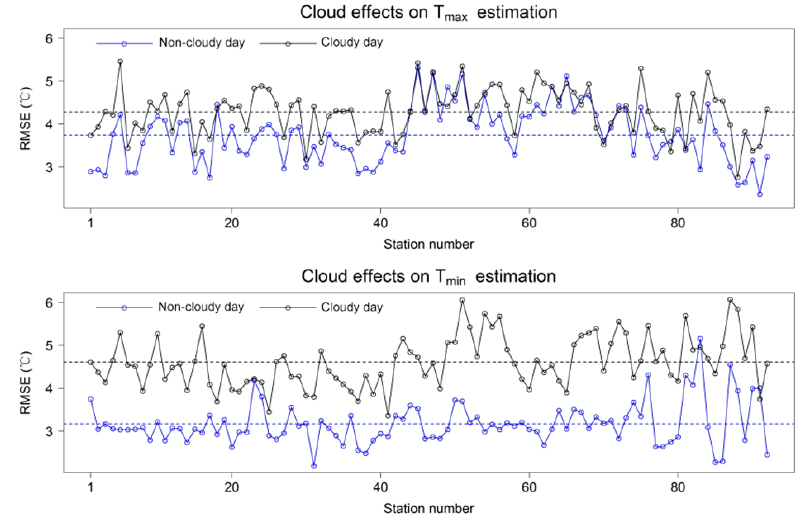
Figure 9. Comparisons of T air estimation accuracy levels based on MODIS LST and CMA observations for “non-cloudy day” and “cloudy day”